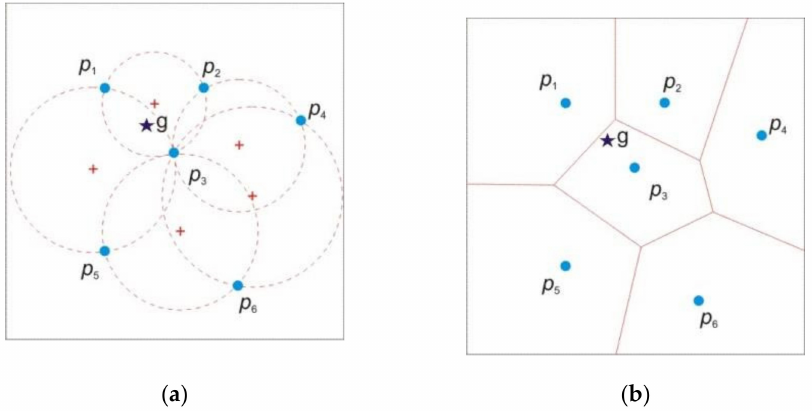
Figure 1. Example of the dual method to calculate the Voronoi diagram. ( a ) Delaunay triangulation. ( b ) Voronoi